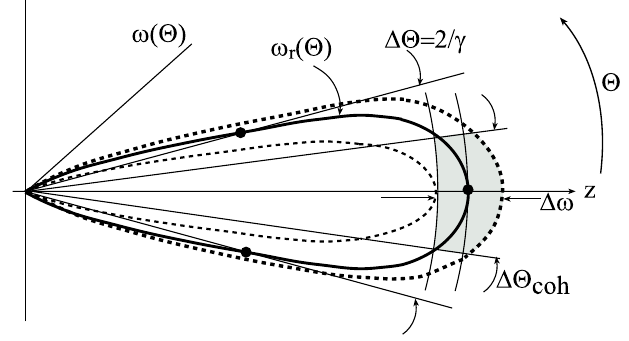
FIG. 2. The FESFER radiation pattern. The shaded section represents the phase-space region of coherent